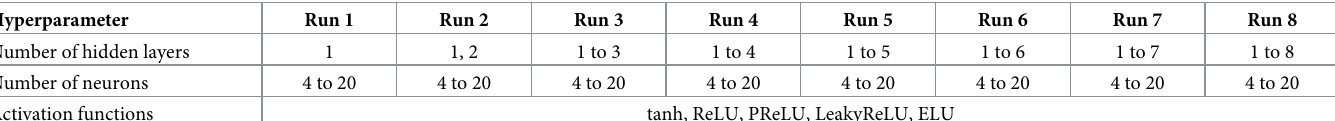
Table 7. Hyperparameter search space.